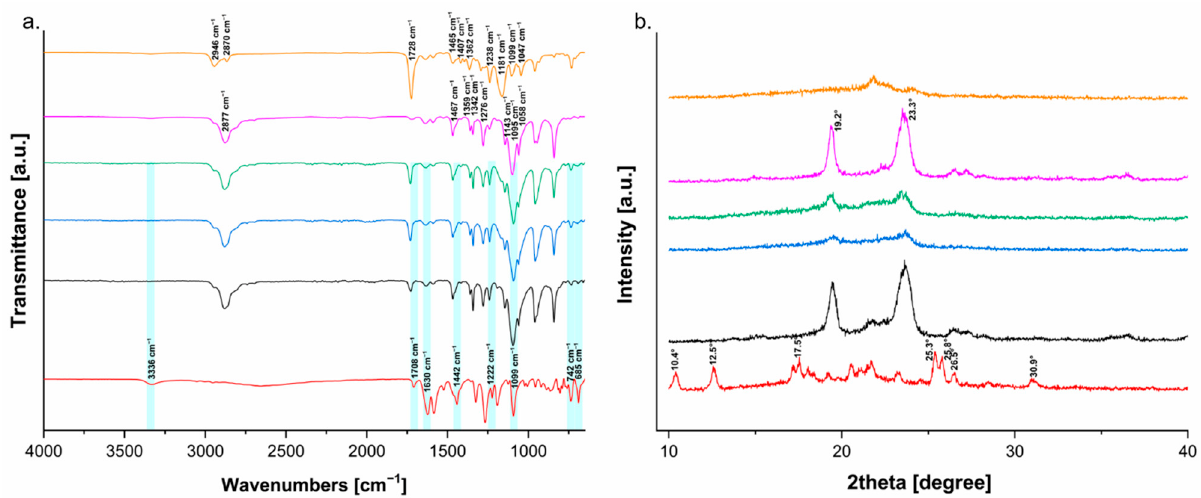
Figure 3. ( a ) FTIR spectra and ( b ) XRD diffraction patterns of Fen (red), formulation 1 (black), for- mulation 2 (blue), formulation 3 (green), PEO extruded (pink) and PCL extruded (orange).